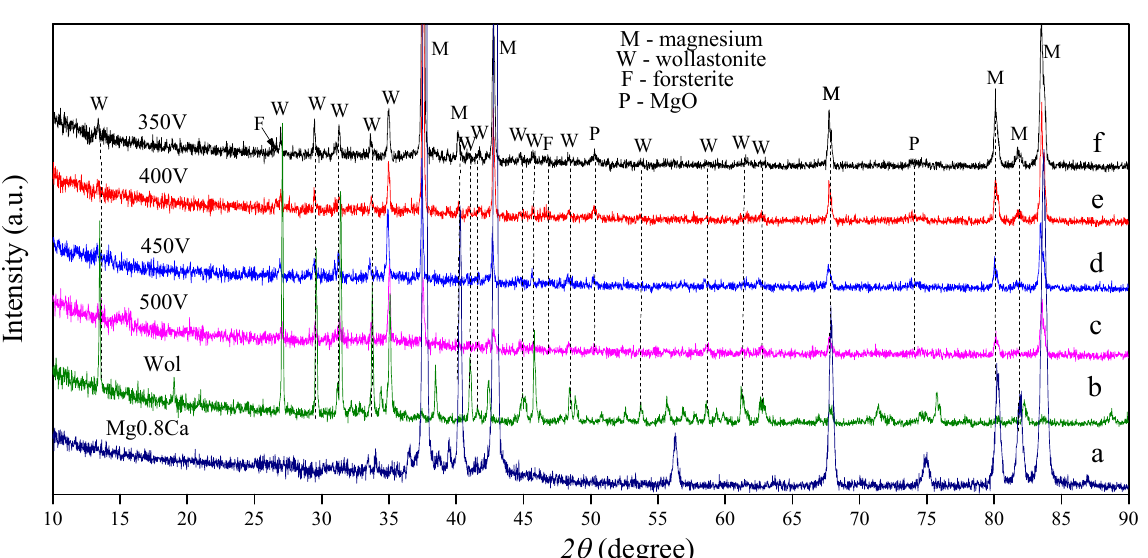
Figure 6. X-ray powder diffraction (XRD) patterns of the Mg0.8Ca alloy ( a ), the wollastonite ( b ), and the W-coatings deposited at the different voltages ( c – f ).